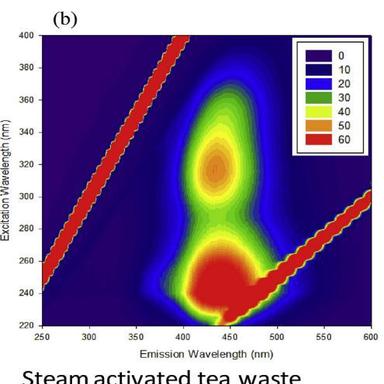
Fluorescence EEMs of biochar samples. (a) Garlic stem BC300 (300 °C), (b) Steam activated tea waste biochar BC700 (700 °C), (c) Perilla BC700 (700 °C).